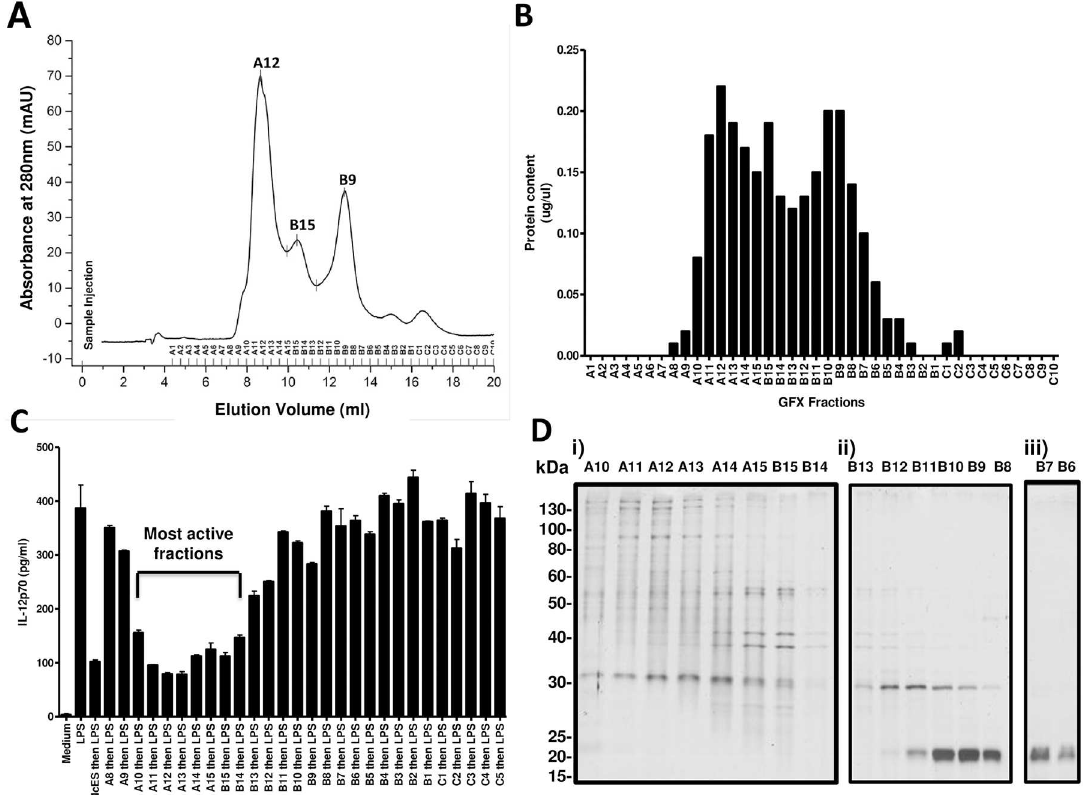
Fig 9. Second line fractionation of McES by Gel Filtration Chromatography and Bio-assessment. Fractions of McES isolated by anion exchangechromatography that display a suppressivepotential on LPS-driven BMDC activation were pooledtogether and loaded on a Superdex200 10/300 column (GE Healthcare) for further fractionation by gel filtration chromatography. The column was equilibratedwith 2 column volumes of PBS (pH 7) before elution with PBS. (A) Superdex 200 chromatogram of McES fractions. The fractions were monitored by recordingthe absorbance at 280 nm for protein content. (B) Protein concentration of eluted McES fractions, as measured by Bicinchoninic acid assay. (C) LPS-drivenIL- 12p70 release followingBMDC pre-exposure to 5 μ g/ml of each McES fractions. Most active GFX fractions are indicated. (D) One-dimensional SDS-PAGE of 1 μ g of the most represented gel-filtration-based McES fractions. Proteins are visually clustered on the gel into 3 groups of molecular weight i.e. group i) 25- > 130kda, group ii) < 15–40kDa and group iii) < 15kDa.